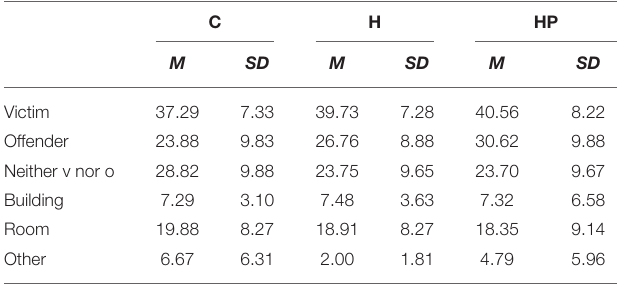
TABLE 3 | Participants’ interpretation of content of the 80 NS related photos by condition. C H